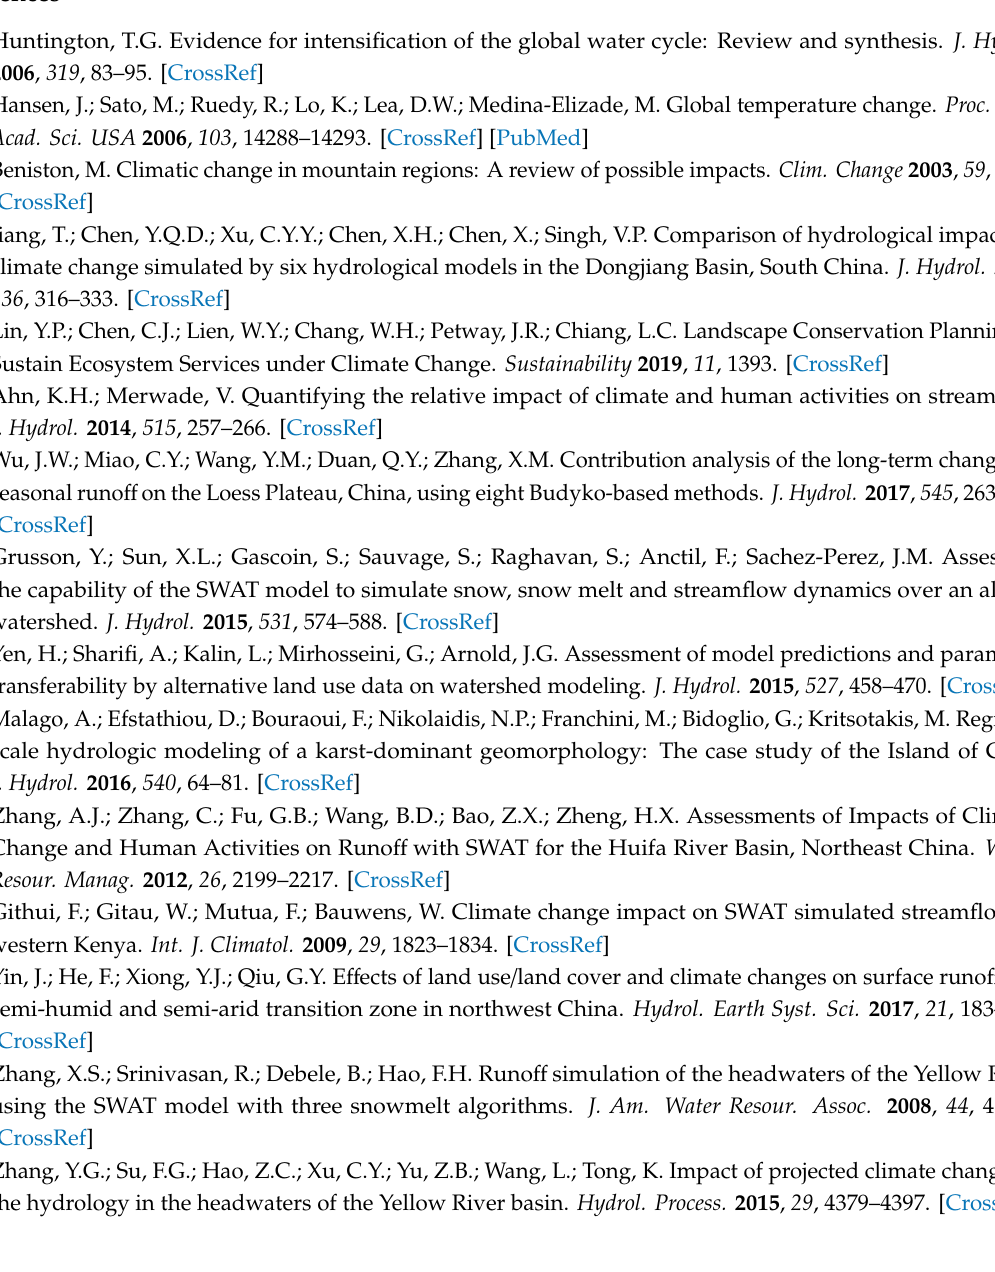
Figure S1: Long-term temporal trend of mean basin precipitation and temperature during 1960–2012 across the headwater region of yellow